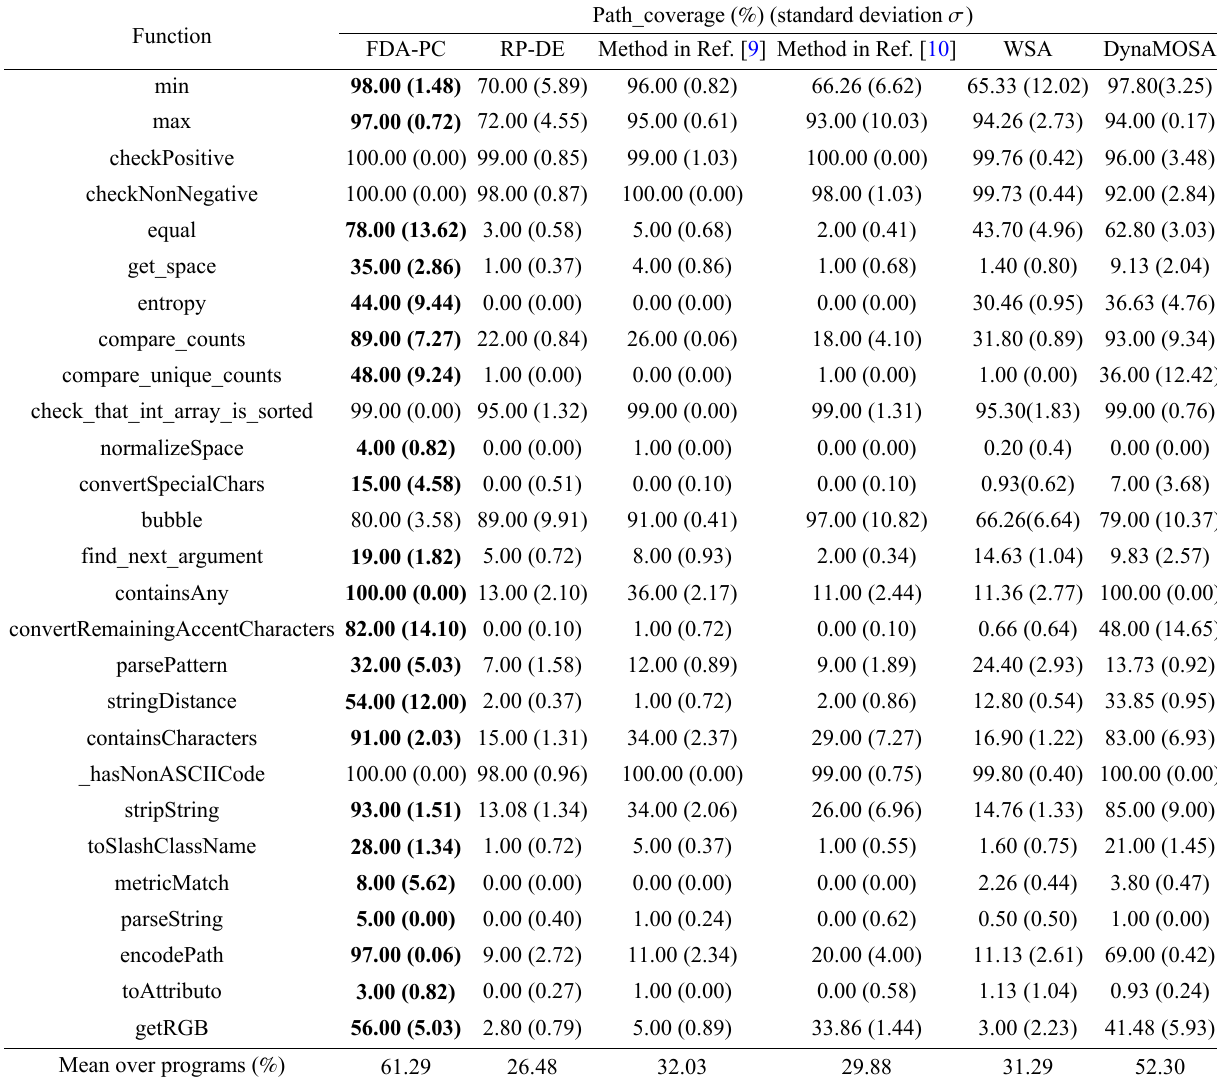
Table 3 Average path_coverage and standard deviation achieved for each program by FDA-PC and alternative approaches.